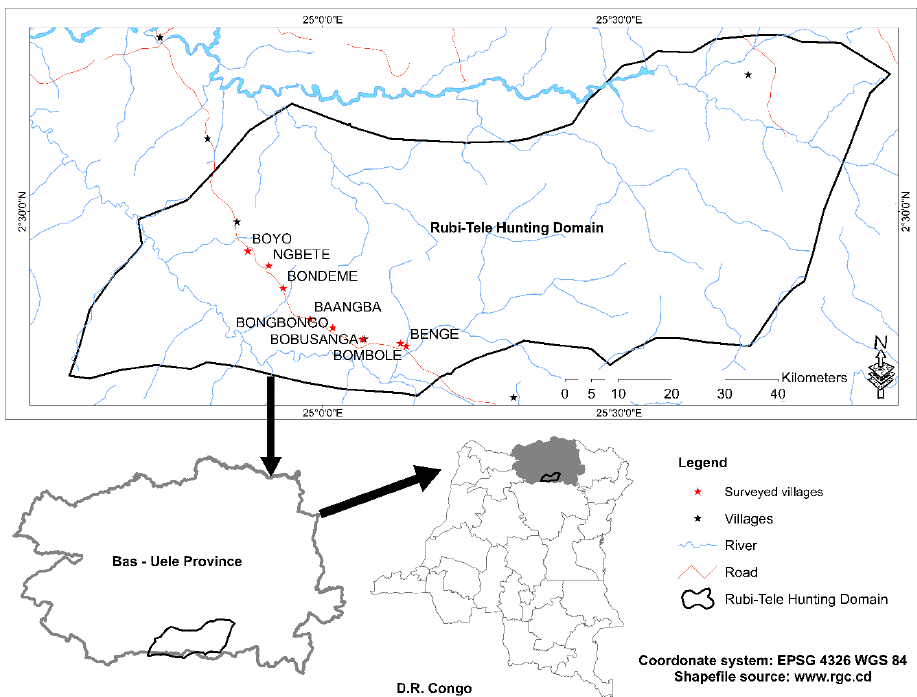
Figure 1. The study area’s map.